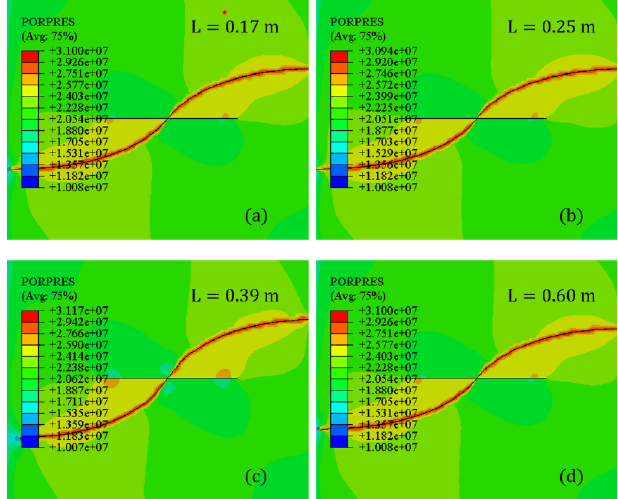
Figure 17. Reorientation behavior of refracturing fractures with different perforation depth (PORPRES present the pore-pressure with enrichments: unit is Pa).